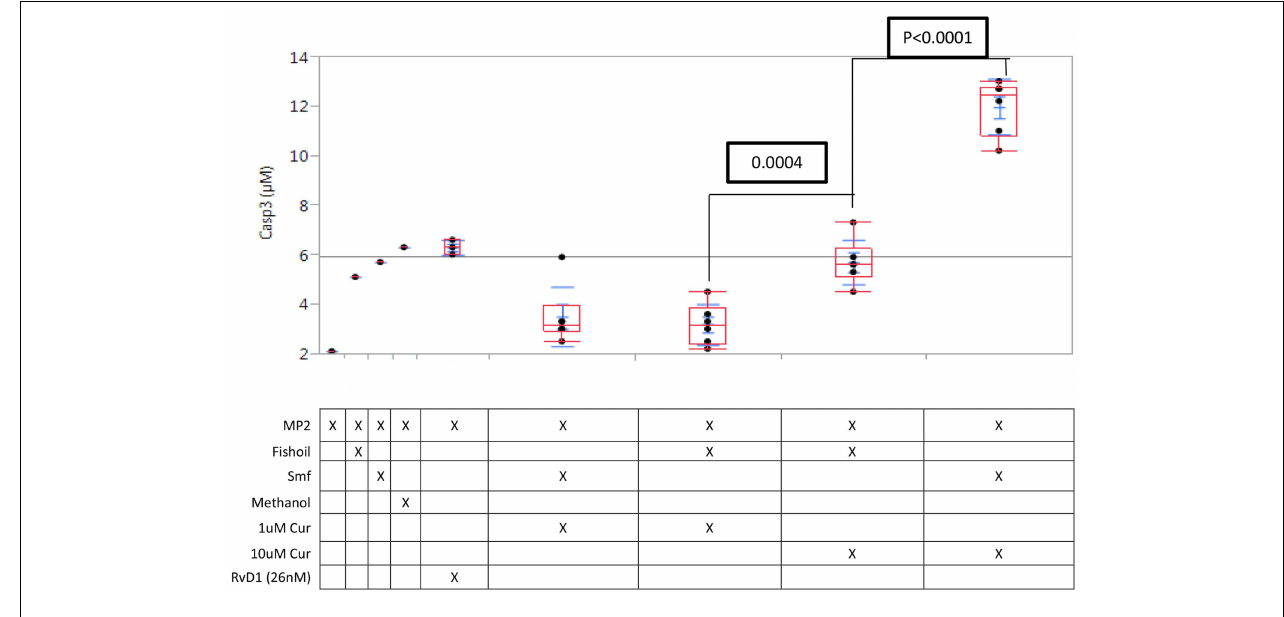
FIGURE 1 | Caspase-3 induction in MP2 cells is potentiated by curcuminoids with ω -3 and anti-oxidants. Replicate MP2 cell cultures ( N = 3 ) in 24-well plates were treated 24h with curcuminoids in Smartfish emulsion or fish oil, the cells were harvested and caspase-3